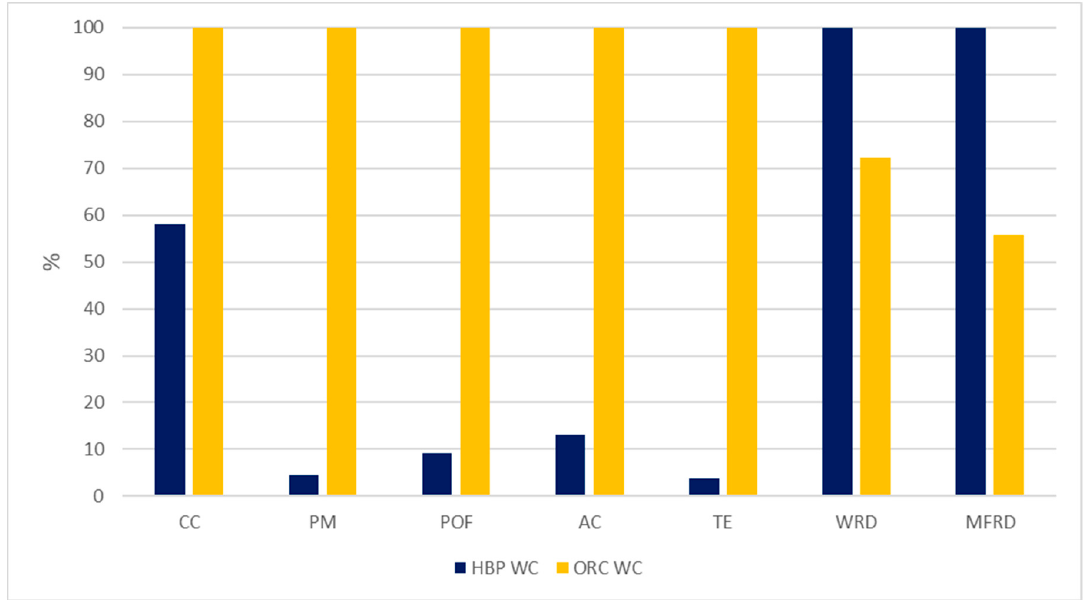
Figure 6. Comparison of HBP technology with ORC technology for 1 MJ of heat. The graph for 1 kWh electricity shows some minor differences due to a slightly different Carnot factor assumed for ORC technology. Values are normalized with respect to the impacts of the most impacting scenario. CC = Climate change, PM = Particulate matter, POF = Photochemical ozone formation, AC = Acidification, TE = Terrestrial eutrophication, WRD = Water resource depletion, MFRD = Mineral, fossil, and renewable resource depletion. WC = wood